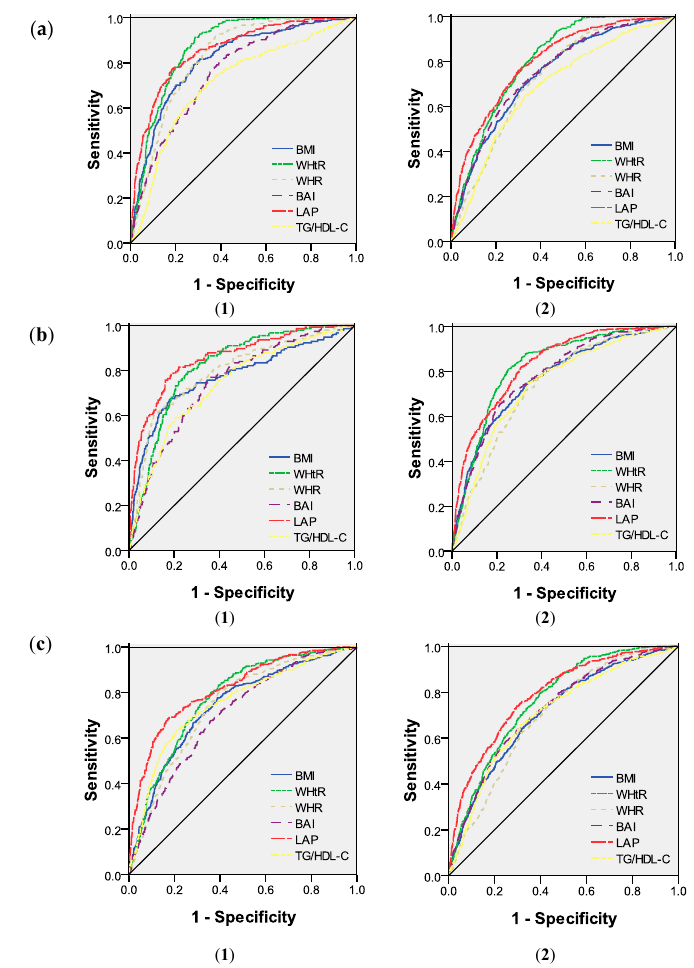
Figure 1. ROC curves for each variable for the screening of MetS in Kazakh males ( 1 ) and females ( 2 ) according to the: IDF ( a ); ATP III ( b ); and JIS ( c ) criteria.